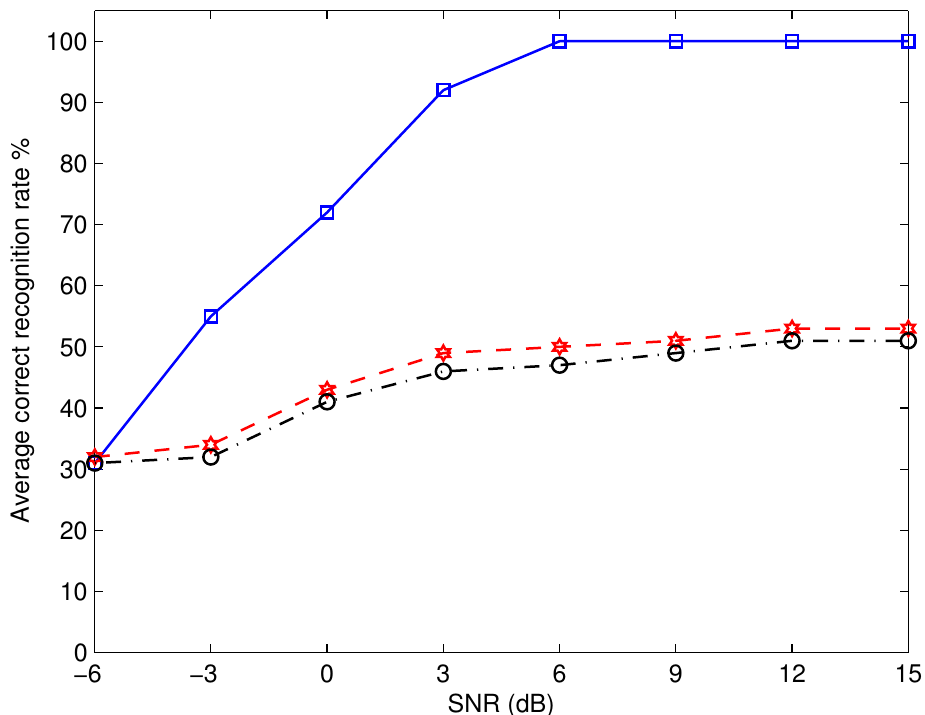
Figure 7. Comparison between the proposed algorithm and that reported in [25]. The proposed algorithm is represented by the square marker, and SVM and NN algorithms of [25] are described by hexagram and circle markers,